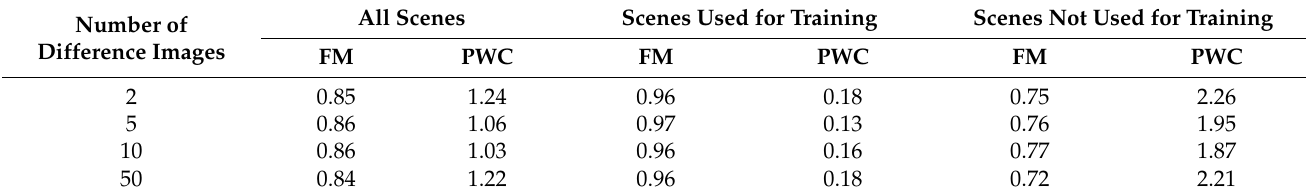
Table 7. A comparison result by changing frame intervals to within 50